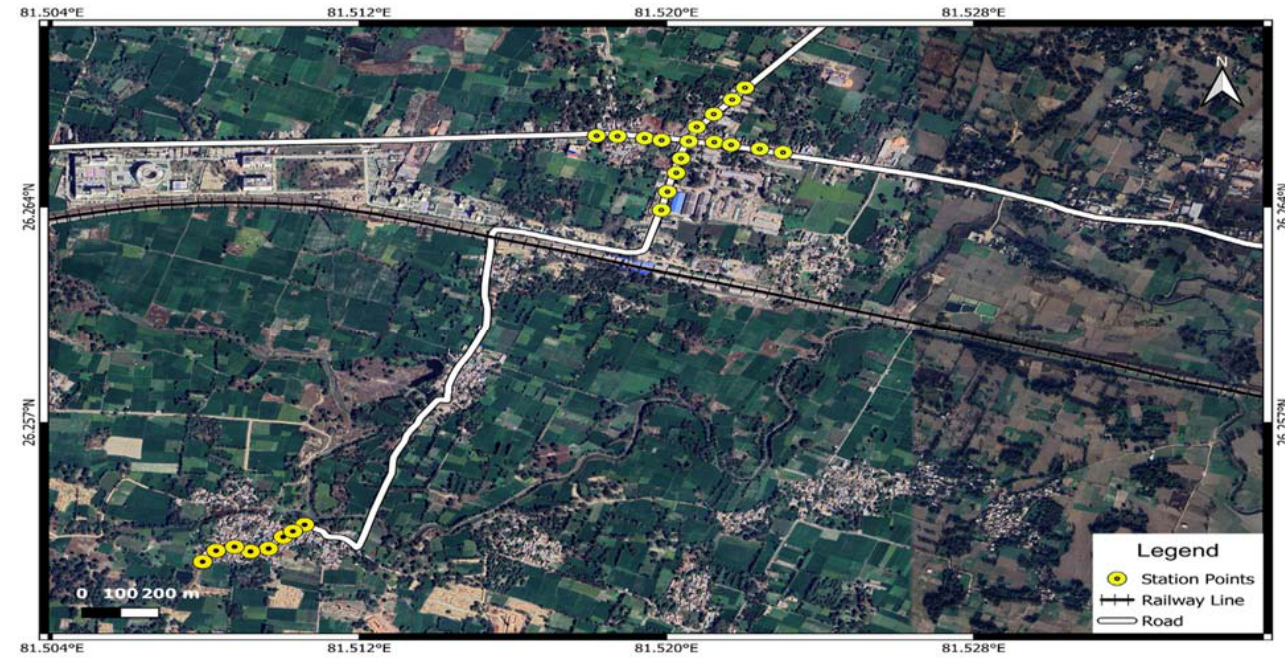
Figure 2. Study area location at Bahadurpur and Pure Ganga Gaon.